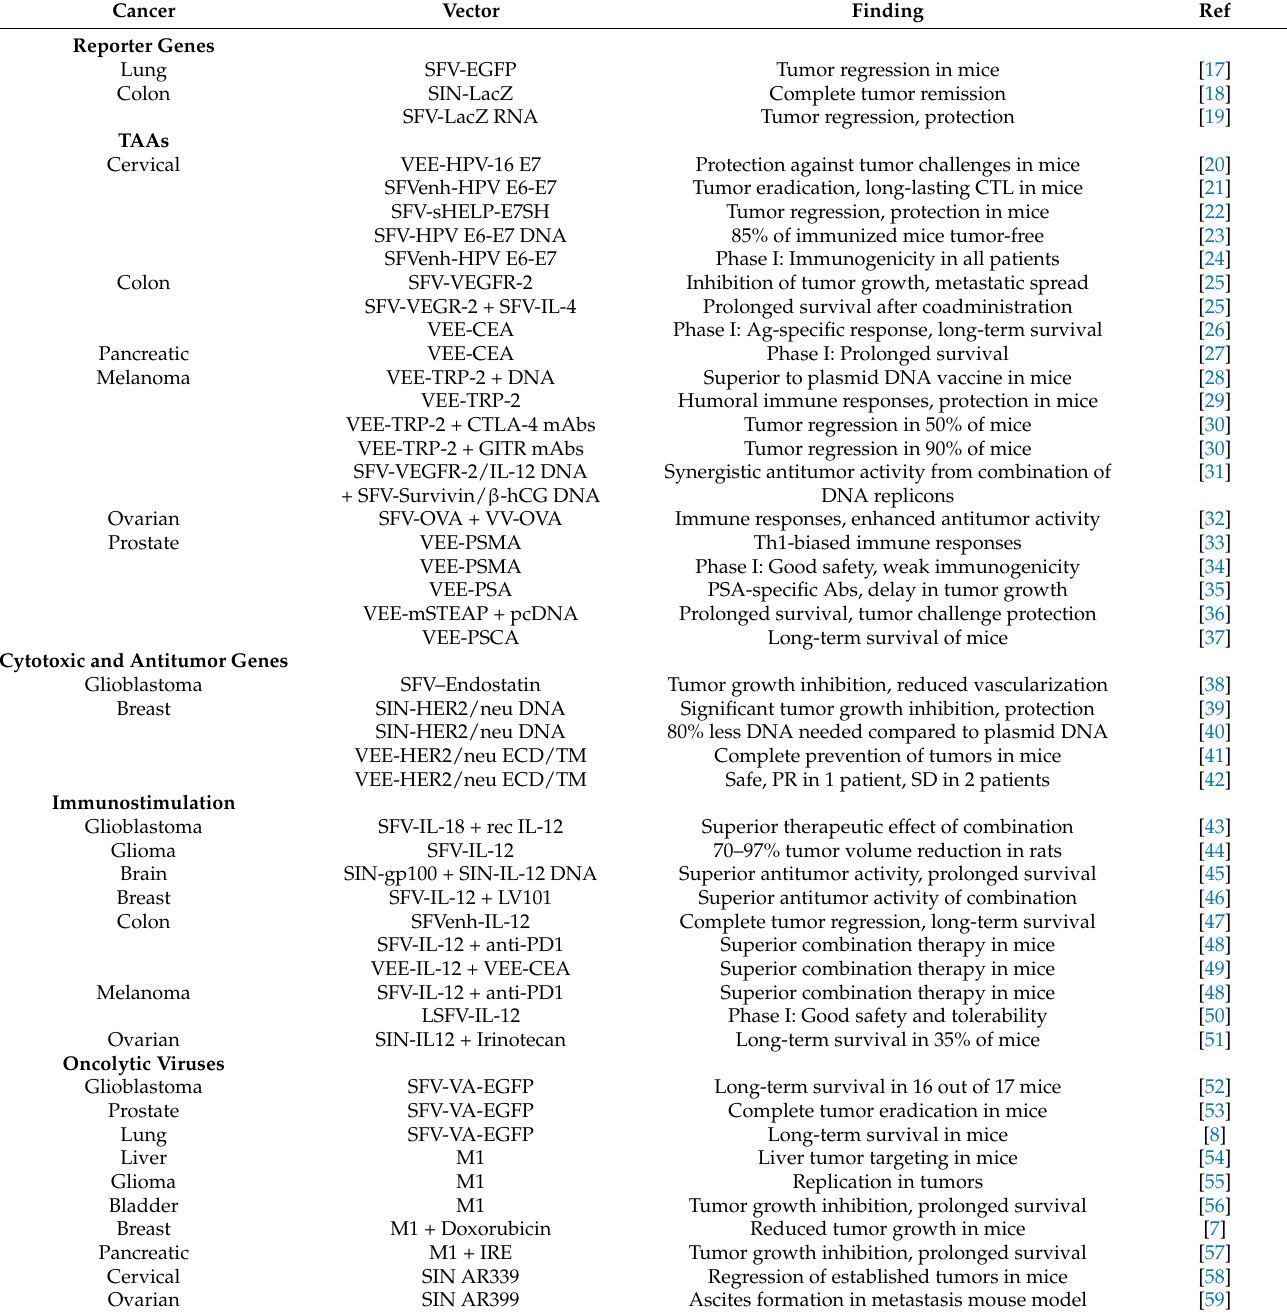
Table 1. Examples of alphavirus-based vaccines against